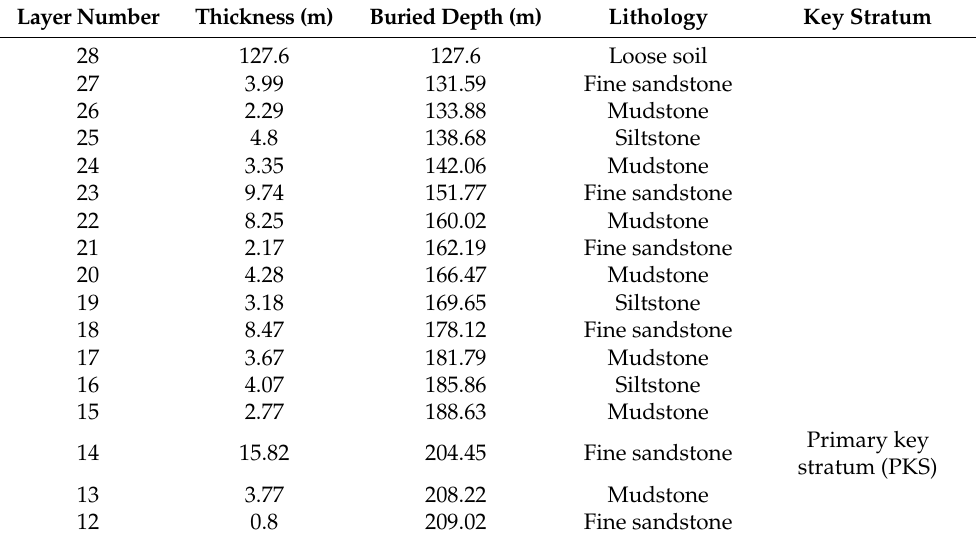
Table 1. Lithology histogram and key stratum identification results of the No. 8–15 borehole. Layer Number Thickness (m) Buried Depth (m)